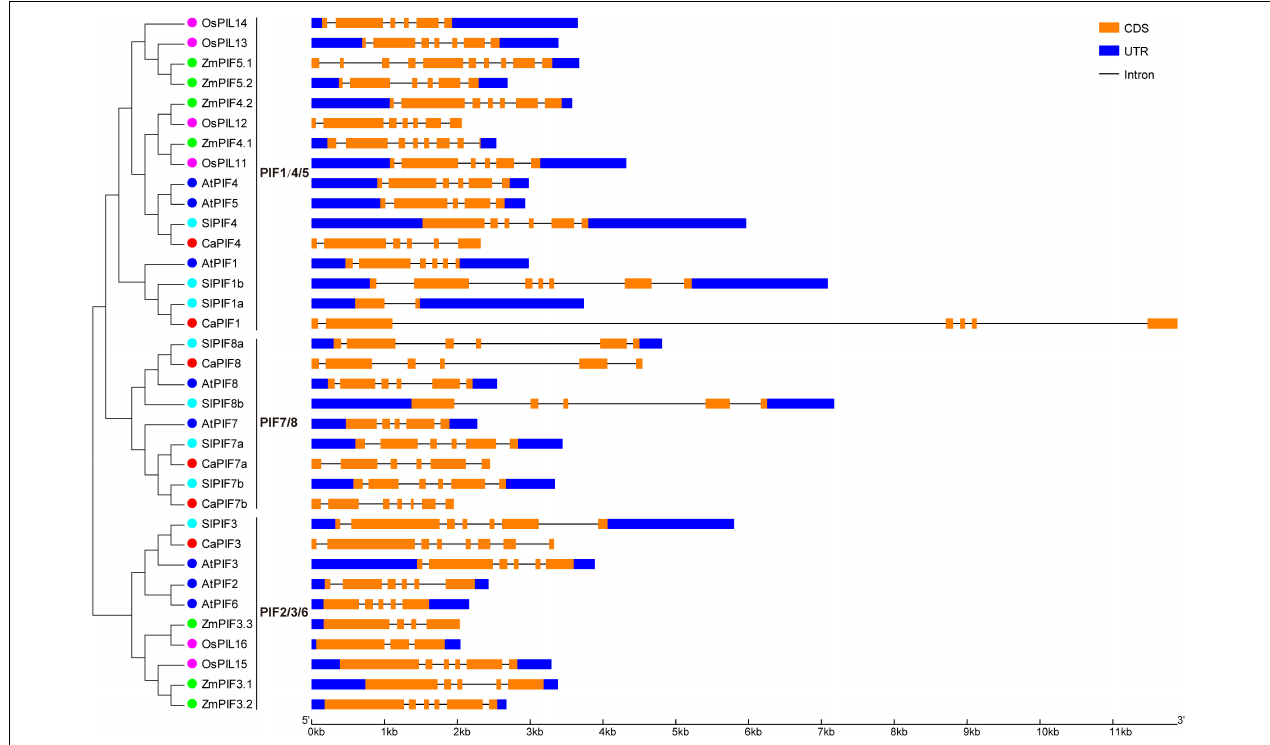
FIGURE 3 | Structural analysis of PIF genes from pepper and other plant species according to the phylogenetic relationship. The CDS and untranslated region (UTR) are presented by orange and blue boxes, respectively.